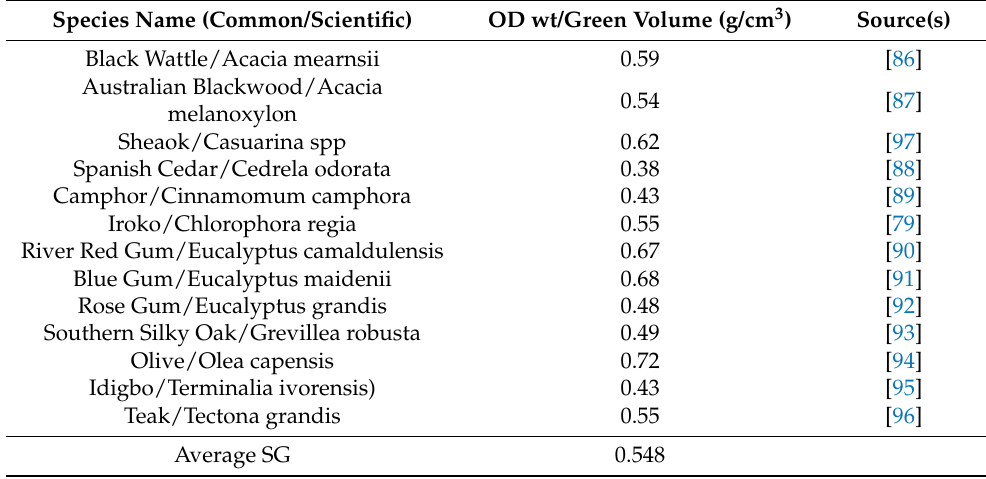
Table A2. Raw data of the hardwood tree species for the basic density calculation.